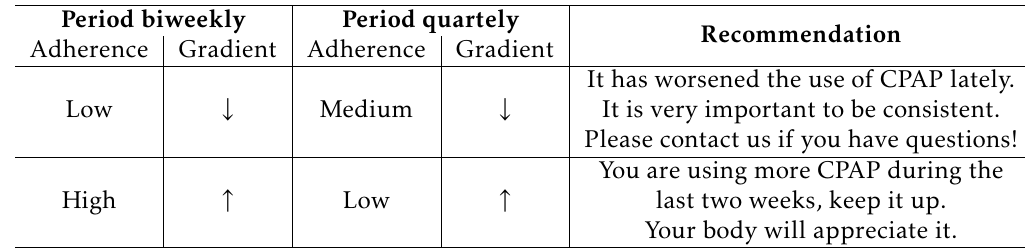
Table 6. Example of